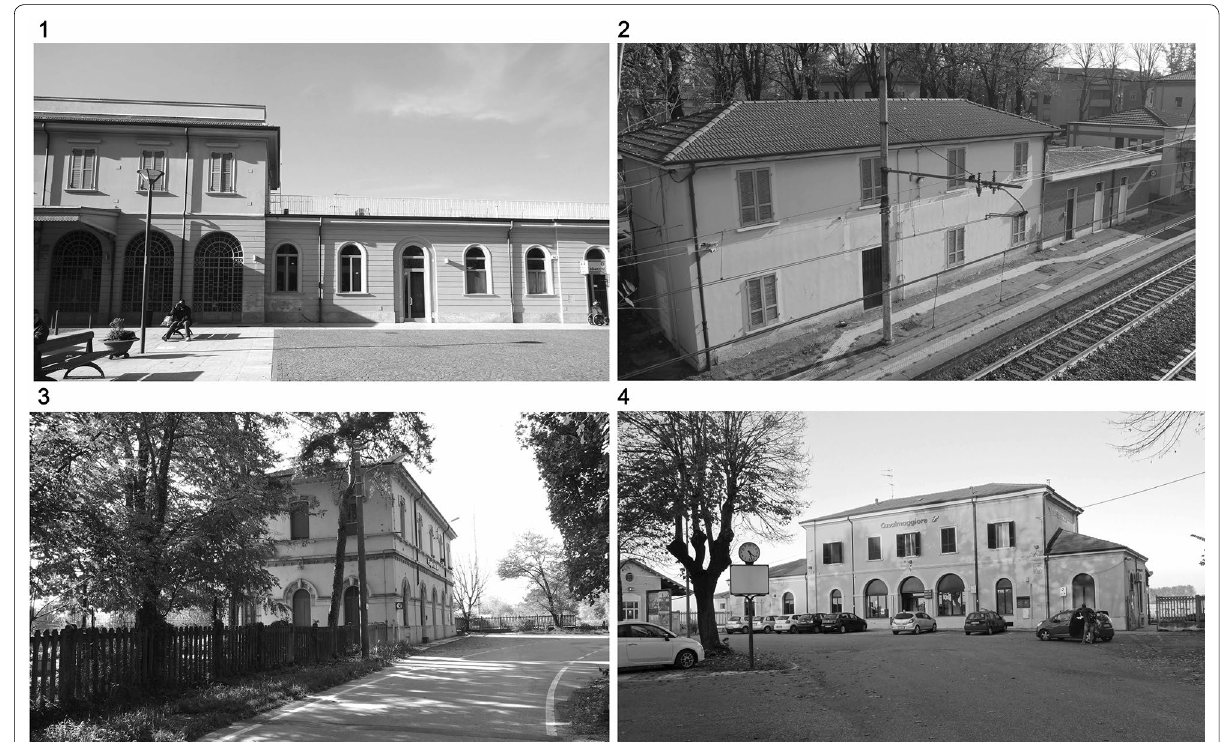
Fig. 7 External view of the stations (1. Tortona, 2. Codogno, 3. Pizzighettone, 4.